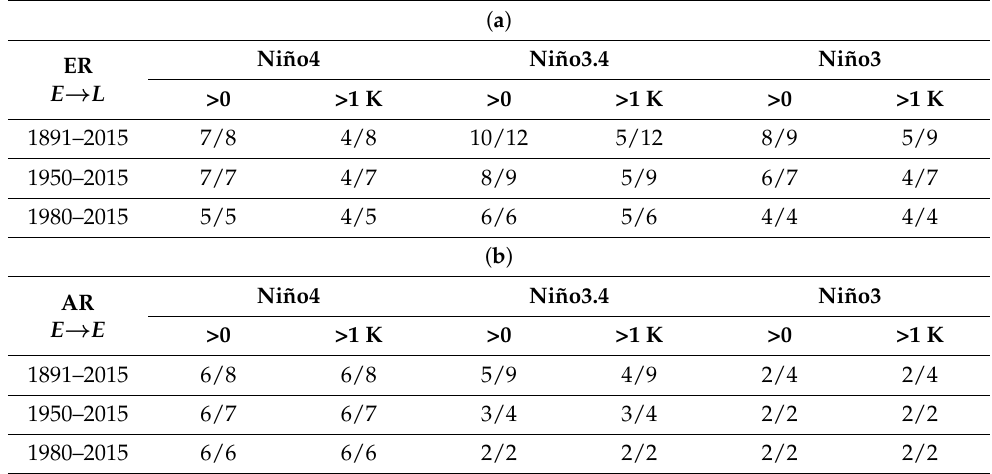
Table 1. Estimates of the frequency of positive and extreme positive (>1 K) SAT anomalies δ T in MJJ (in the numerator) and the total number of phase transitions (in the denominator) using the indices Niño3, Niño3.4 and Niño4 for different periods, 1891–2015, 1950–2015 and 1980–2015, (a) for ER during the E → L transition; (b) for AR during the E → E